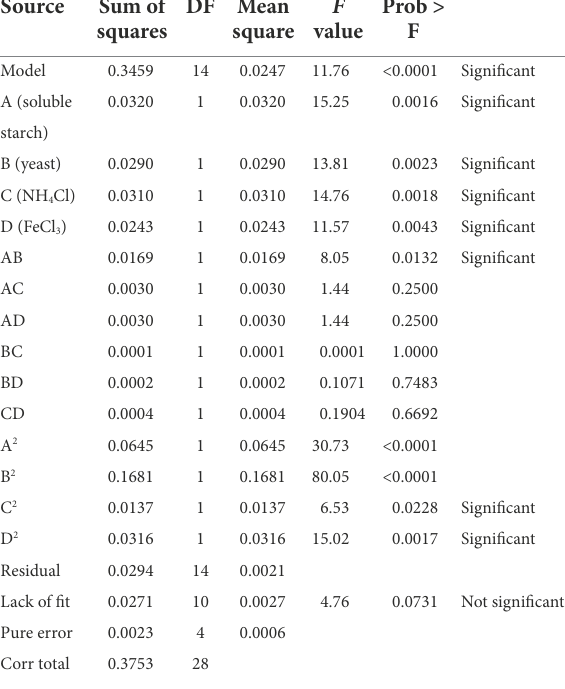
TABLE 6 ANOVA analysis for response surface quadratic